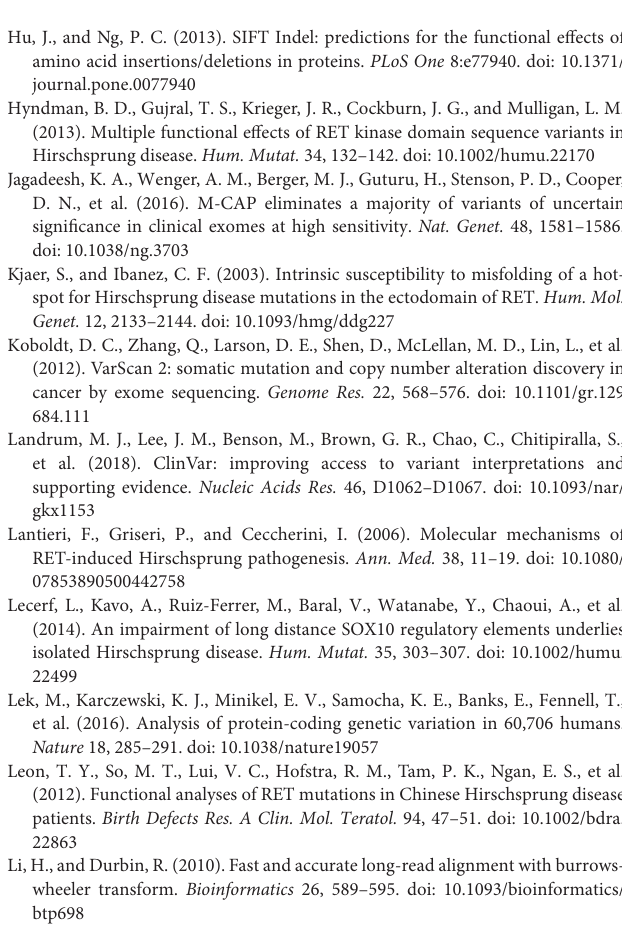
TABLE S1 | The evaluation of the pathogenicity of the 18 dominant variants using bioinformatics